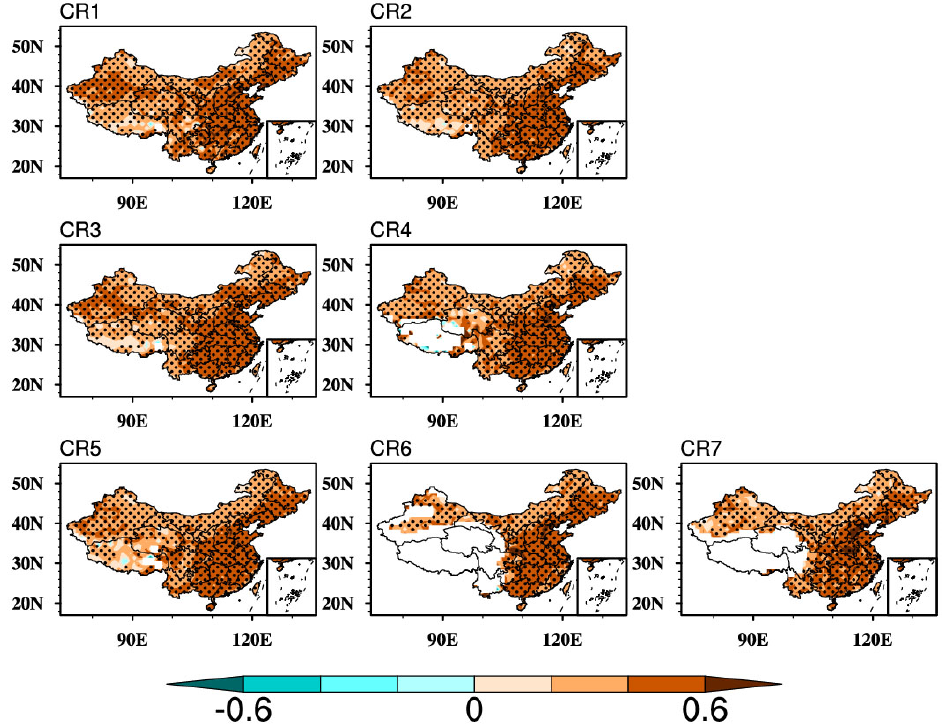
Figure 8. Same as Figure 5 but for correlation coefficient between TCC and AOD.